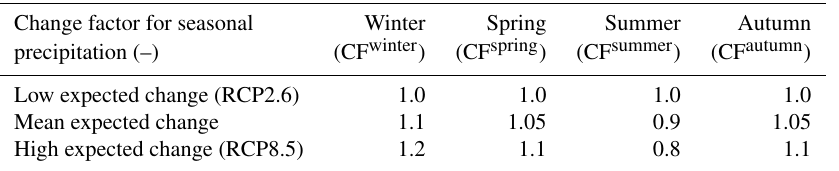
Table 4. Expected seasonal changes to precipitation in Denmark based on data from Table 5 of Olesen et al. (2014) and linearly scaled midpoint values. Change factor for seasonal Winter Spring